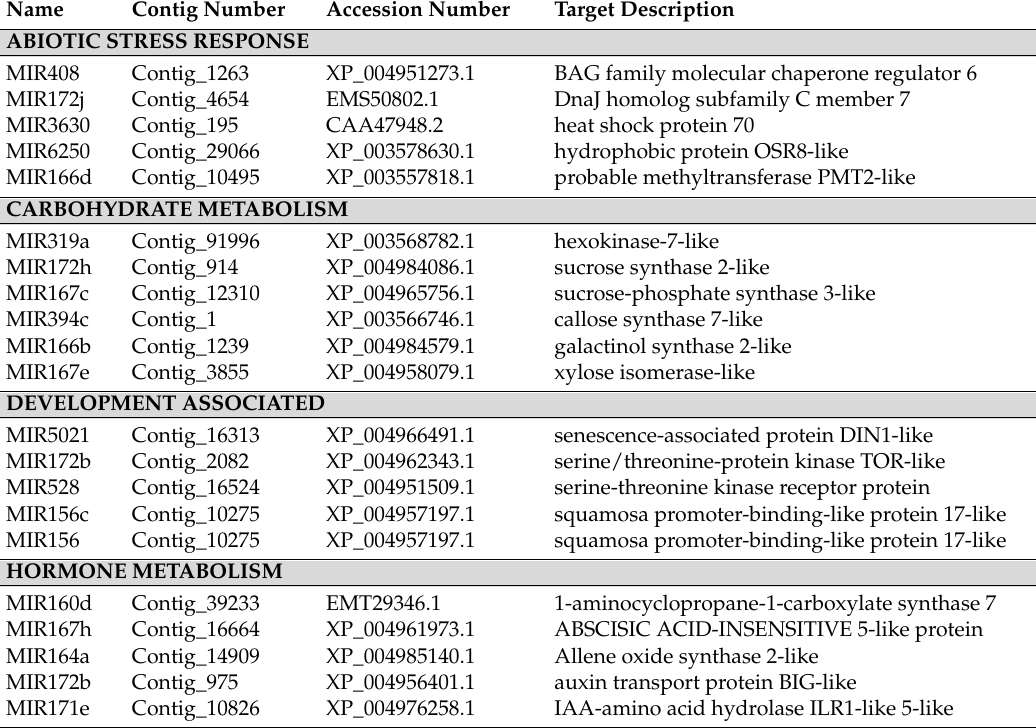
Table 1. MapMan functional categories of potential targets of differentially expressed conserved miRNAs during dehydration in Tripogon loliiformis